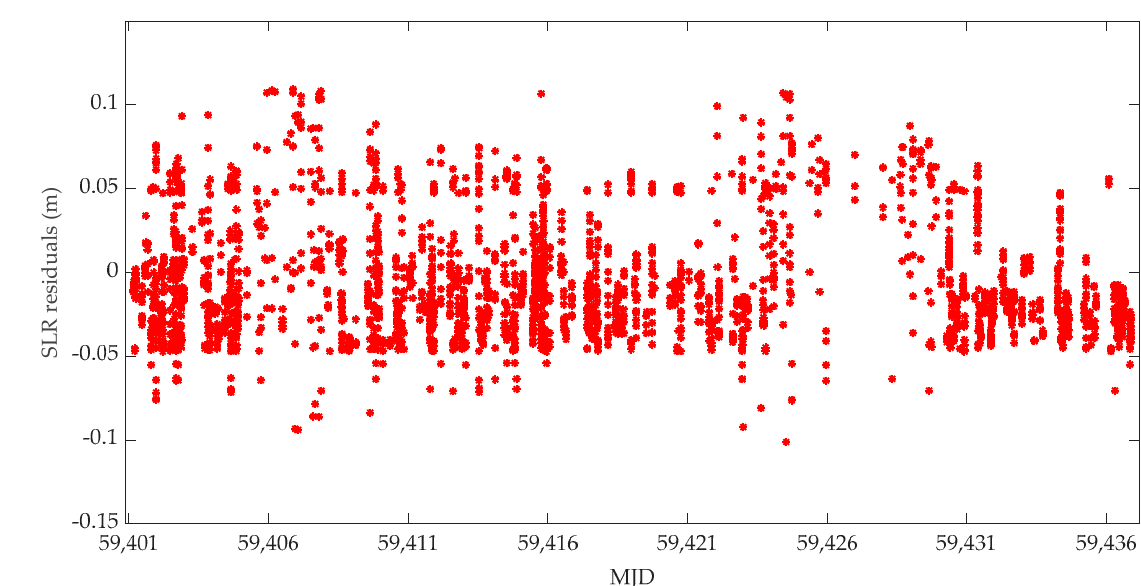
Figure 10. The variation of SLR residuals for HY2D satellite.